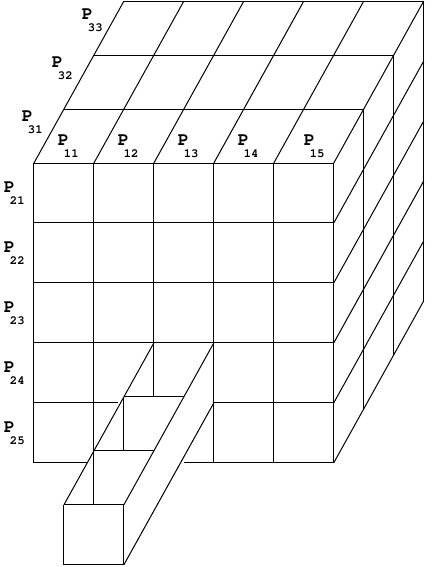
Figure 1: A 3-parameter Zwicky box containing 75 cells or ‘configurations’ (Zwicky, 1969, p.